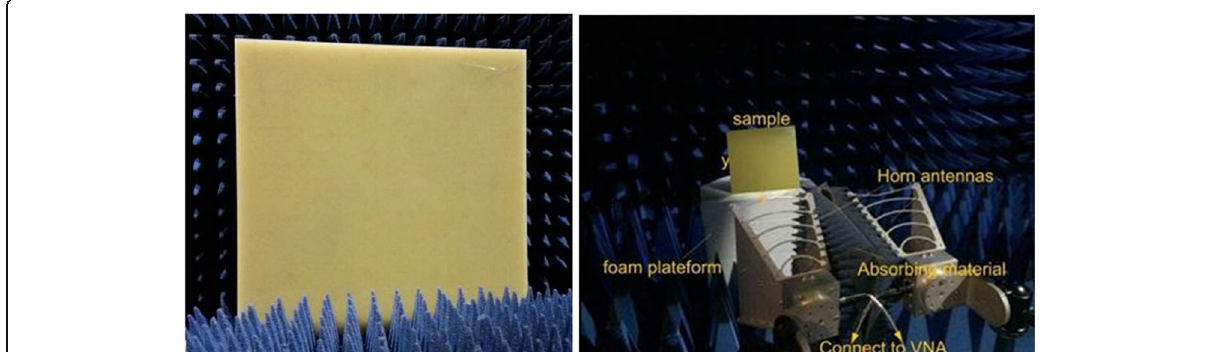
Fig. 8 Prototypes of the proposed ultra-broadband PMA devices in a microwave anechoic